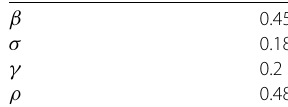
Table 1 Ebola specific parameters